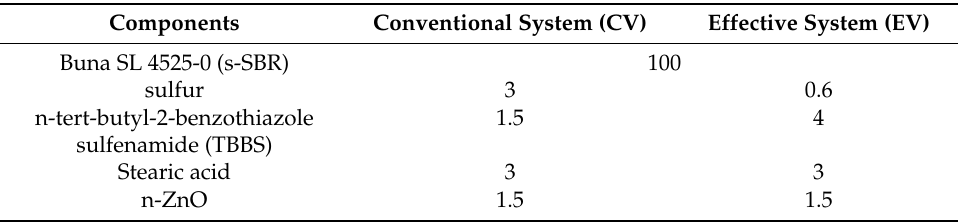
Table 5. Composition (phr) of the rubber